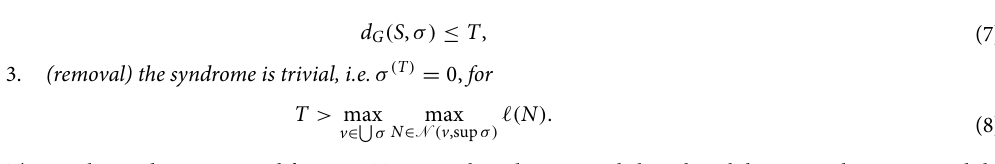
Figure 2. A family of rhombic dodecahedral lattices with boundaries. ( a ) Construction of the L = 3 lattice from the cubic lattice. We show the initial cubic lattice as well as the final rhombic dodecahedral lattice. ( b ) The L = 3 lattice. The front and back boundaries are smooth (syndromes must form closed loops) and the other boundaries are rough (open loops of syndrome can terminate). ( c ) An example of a open loop of syndrome terminating on one of the rough boundaries (light yellow edges). ( d ) A syndrome on the smooth boundary (light yellow edges). With the sweep direction � ω = − ( 1, 1, 1 ) , the ringed vertex does not satisfy the trailing location